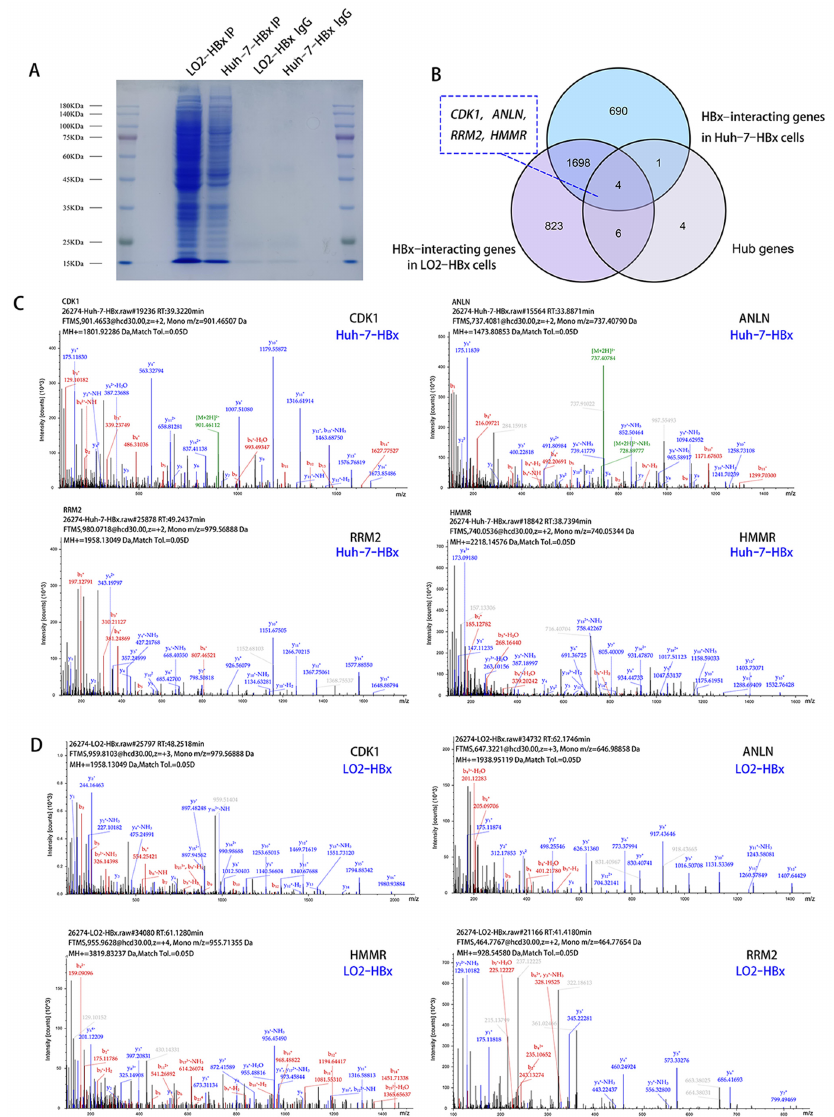
Figure 9. Identification of HBx-interacting proteins. ( A ) The co-immunoprecipitated mixture was separated using SDS-PAGE and stained with Coomassie blue. ( B ) Venn diagram of overlapping Figure 9 . Identification of HBx − interacting proteins. ( A ) The co − immunoprecipitated mixture was HBx-interacting proteins and hub genes. Identification of CDK1, RRM2, ANLN, and HMMR from the separated using SDS − PAGE and stained with Coomassie blue. ( B ) Venn diagram of overlapping HBx-interacting protein complex extracted from LO2-HBx cells ( C ) and Huh-7-HBx cells ( D ) using Co-IP/MS